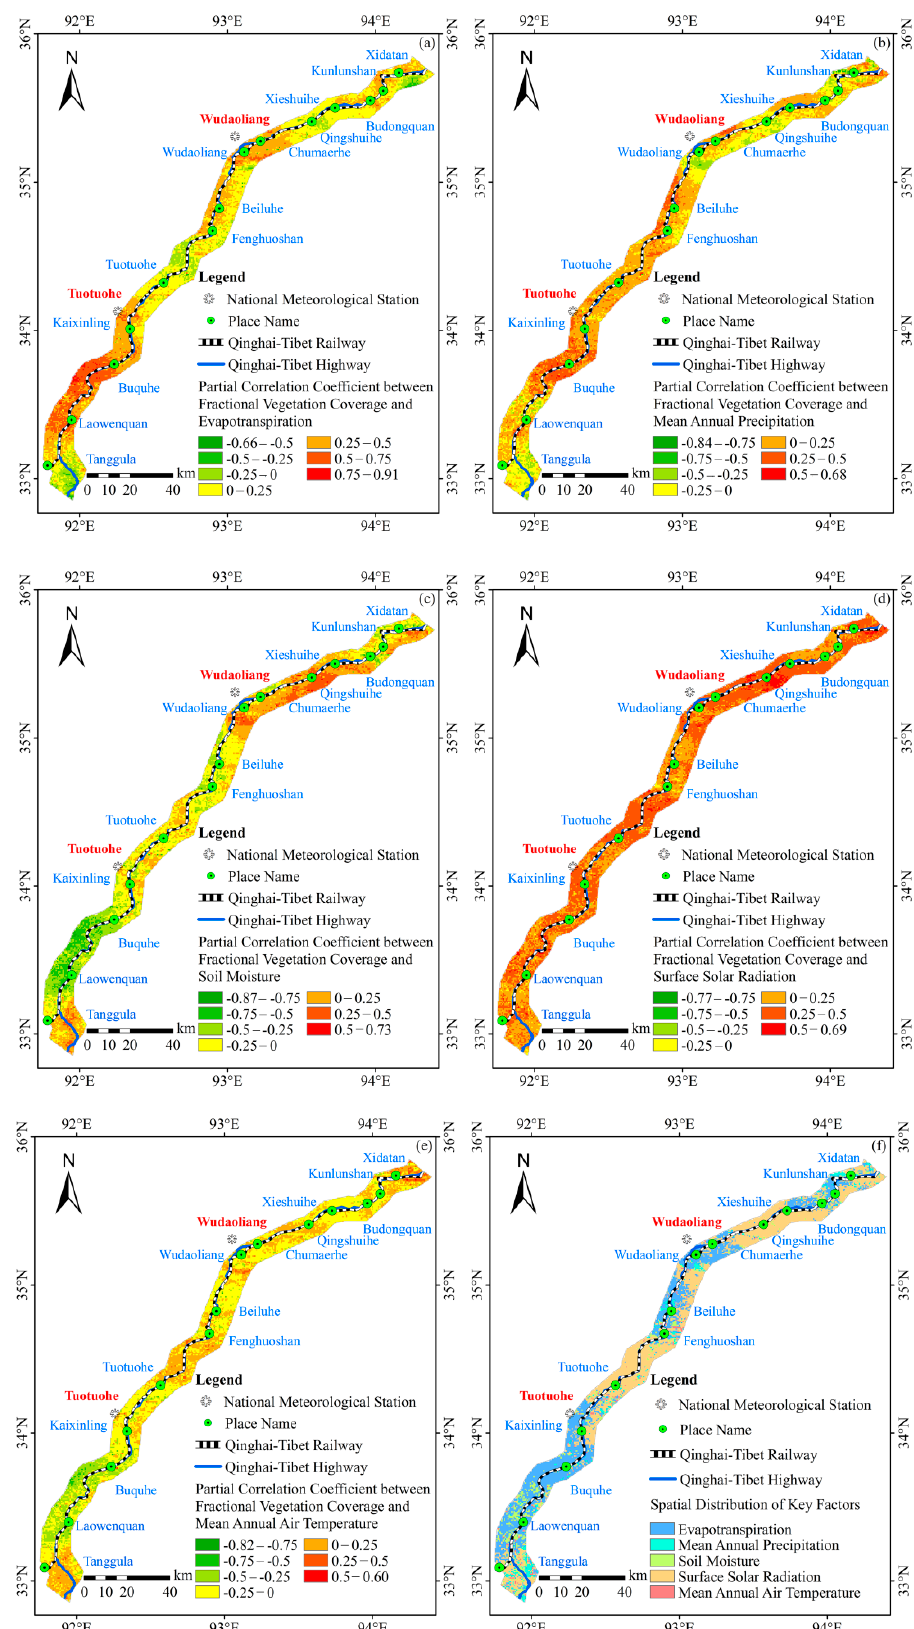
Figure 11. Spatial distribution of the partial correlation coefficient between FVC and driving factors, and key factors affecting FVC: ( a ) ET; ( b ) MAP; ( c ) SM; ( d ) SR; ( e ) MAAT; ( f ) key factors. FVC, a risk factor of ecological environmental risk, was also affected by other risk factors to varying degrees. Therefore, the factor with the maximum absolute value of the partial correlation coefficient on the pixel was selected as the main risk factor. It can be seen, from Figure 11f, that, in the entire study area, ET, FVC, MAP, SM, SR and MAAT affected 39.48%, 5.76%, 7.66%, 45.09% and 2.01% of the area, respectively. Therefore, the influence degree of each influencing factor on FVC in the study area was expressed as SR > ET > SM > MAP > MAAT, indicating that SR and ET were the main influencing factors of FVC in the study area from 2003 to 2016. 4.2.3. Driving Factor Analysis of SM The partial correlation between the SM and ET, MAP, FVC, SR and MAAT in the study area from 2003 to 2016 was analyzed. The spatial distribution characteristics are shown in Figure 12 and the spatial analysis results are shown in the Supplementary Ma- terials (Table S9).